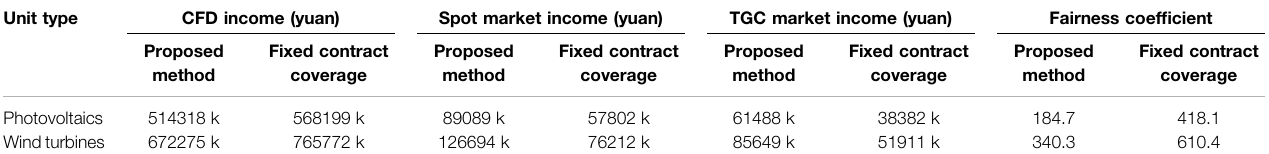
TABLE 3 | Comparisons between the results attained by the proposed method and the fi xed contract coverage.